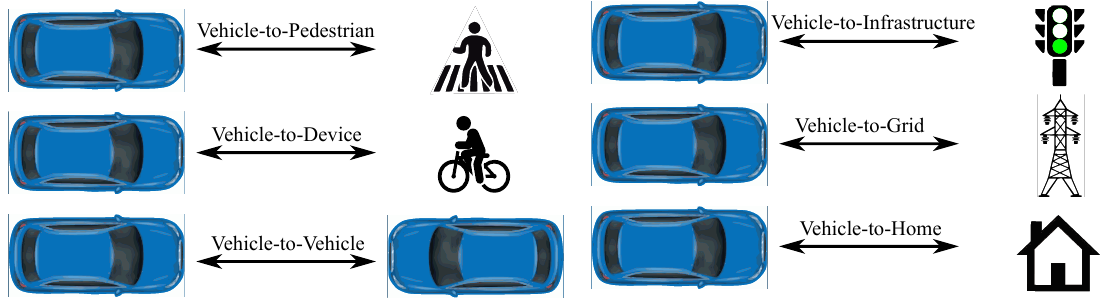
Figure 1. Vehicle-to-everything scenarios communication.